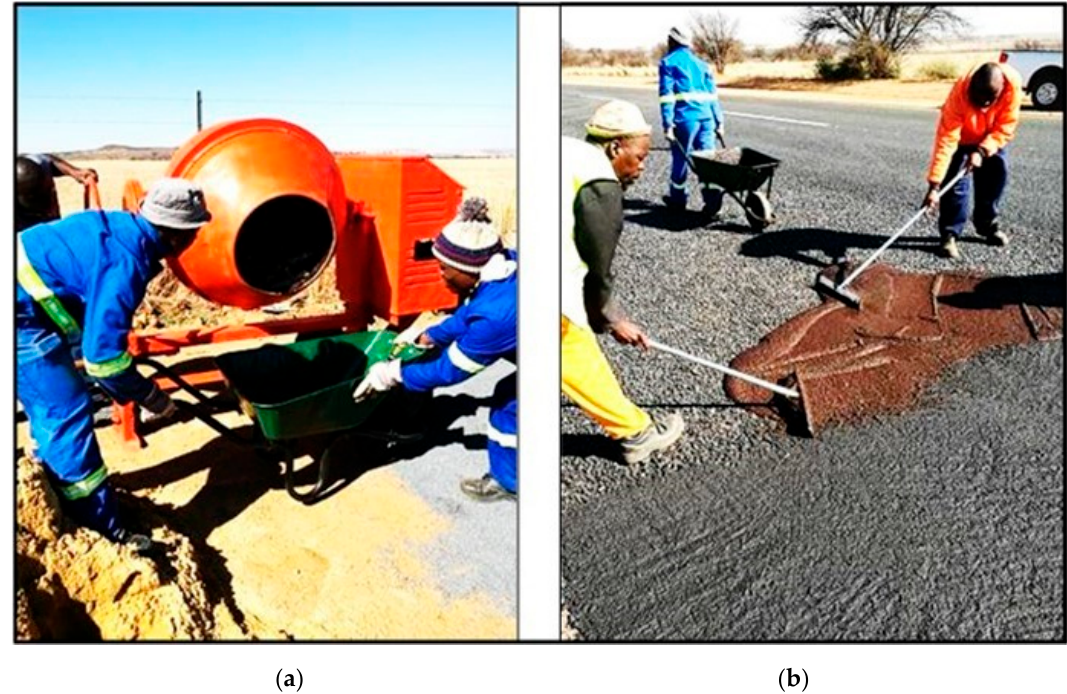
Figure 5. On-site mixing ( a ) and placement ( b ) of the anionic NME-modified slurry mix.